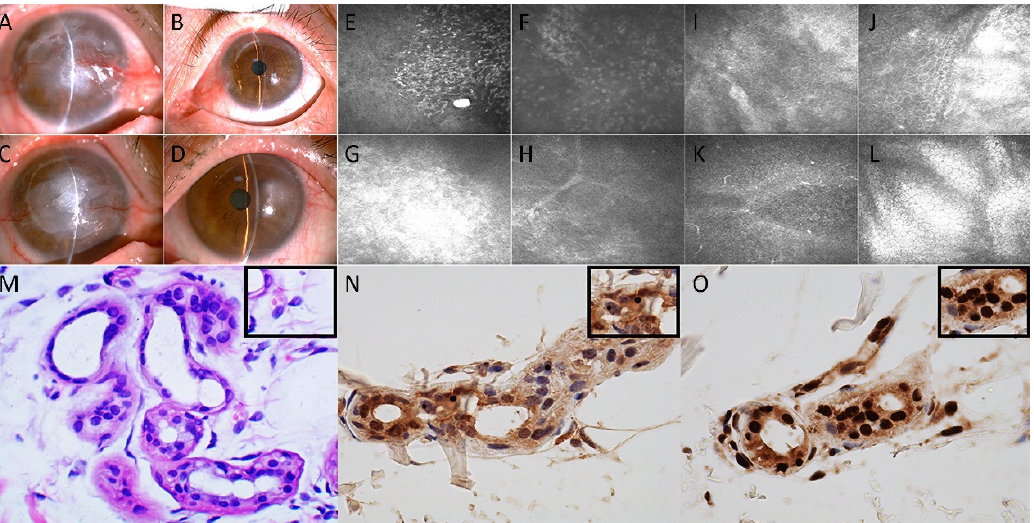
Figure 1. Anterior segment photography obtained in May of 2016 ( A , B ) and May of 2018 ( C , D ). In vivo confocal microscopy (IVCM) of the right eye demonstrated alterations in the epithelial basal cell layer of cornea ( E ) and stroma ( F – H ) in May of 2016, and alterations in the corneal epithelium ( I , J ), basal epithelial layer ( K ) and endothelium ( L ) in May of 2018. Hematoxylin–eosin staining ( E , H , M ) and immunohistochemical staining with anti-p62 antibody ( N ) and anti-ubiquitin antibody ( O ) of the skin biopsy with the magnified area showed the neuronal intranuclear inclusions.